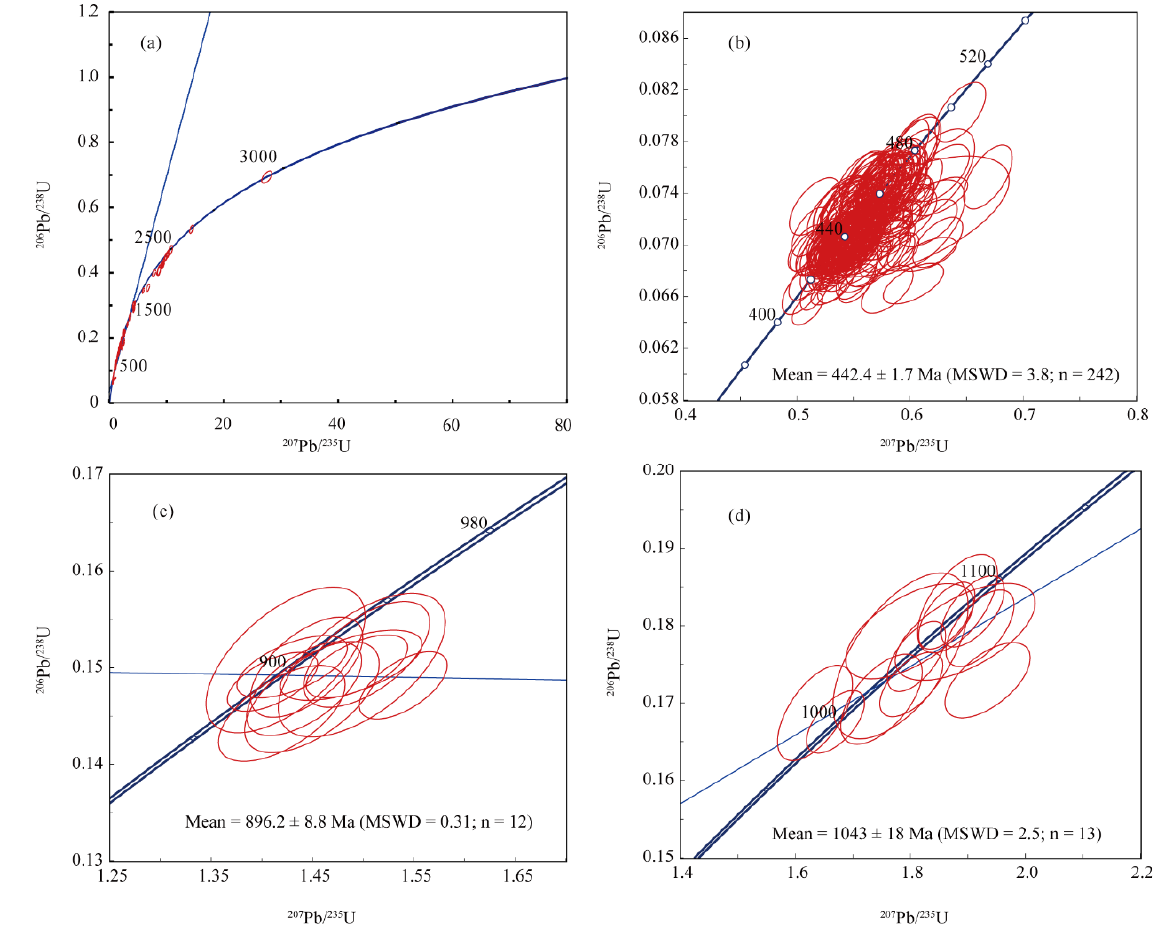
Figure 7. Concordia plots of zircon dating results for the Tanghu granites. ( a ) shows concordia plot of the whole data; ( b – d ) show concordia plot and mean average ages of Ordovician, Neoproterozoic and Mesoproterozoic zircons, respectively. The red circle, bule solid lines and bule dashed lines represent the radius error for a single spot, concordant curve and unconcordant curve, respectively.